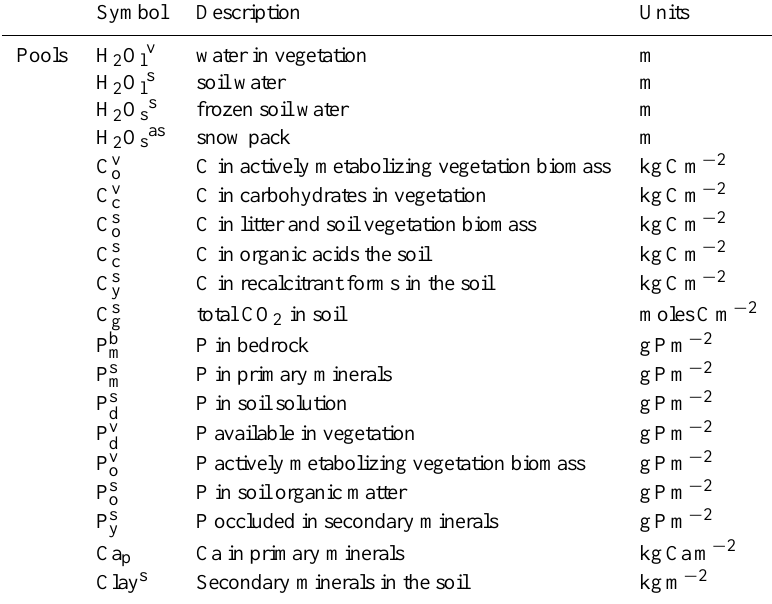
Table A1. Description of model variables relevant for the P cycle (part 1 of 3).